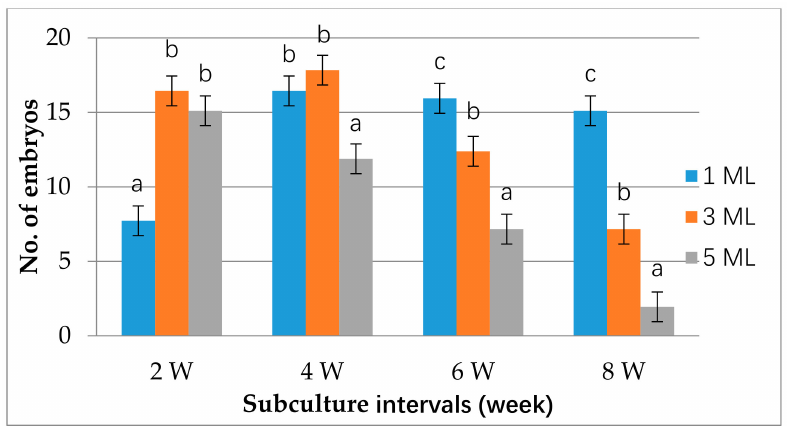
Figure 3. Effects of inoculation volume of suspension cells and subculture intervals on embryo production. The suspension cells were subcultured in H+H medium, and then the embryos were produced on EME-malt medium. The embryos were counted after 10 to 12 weeks of incubation on an EME-malt medium. All embryos produced from all genotypes of an individual subculture interval (i.e., 2 W) of the same inoculation volume (i.e., 1 mL) were considered as one group. The statistical difference ( p ≤ 0.05) among the means was analyzed by Duncan’s multiplerange test using SPSS (version 23), and results were expressed as mean ± standard error of three independent